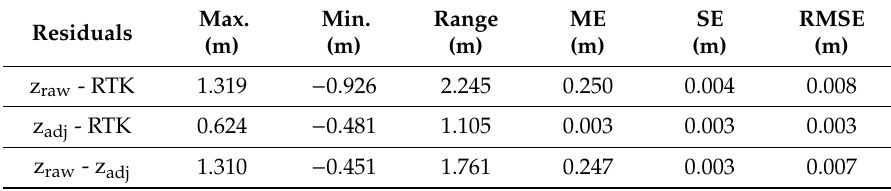
Figure 5. Accuracy assessment of LiDAR-derived DEM (z raw ) and DEM-corrected (z adj ) as compared to ground-truth elevation (RTK) collected on Fire Island, New York. ( a ) Histogram of surface elevation within emergent herbaceous wetlands referenced with respect to NADV88; and ( b ) frequency of occurrence for residuals (vertical errors) of z raw and z adj with respect to RTK. Table 8. Summary of residual analysis (vertical error) within emergent herbaceous wetlands of Fire Island, New York. Max.